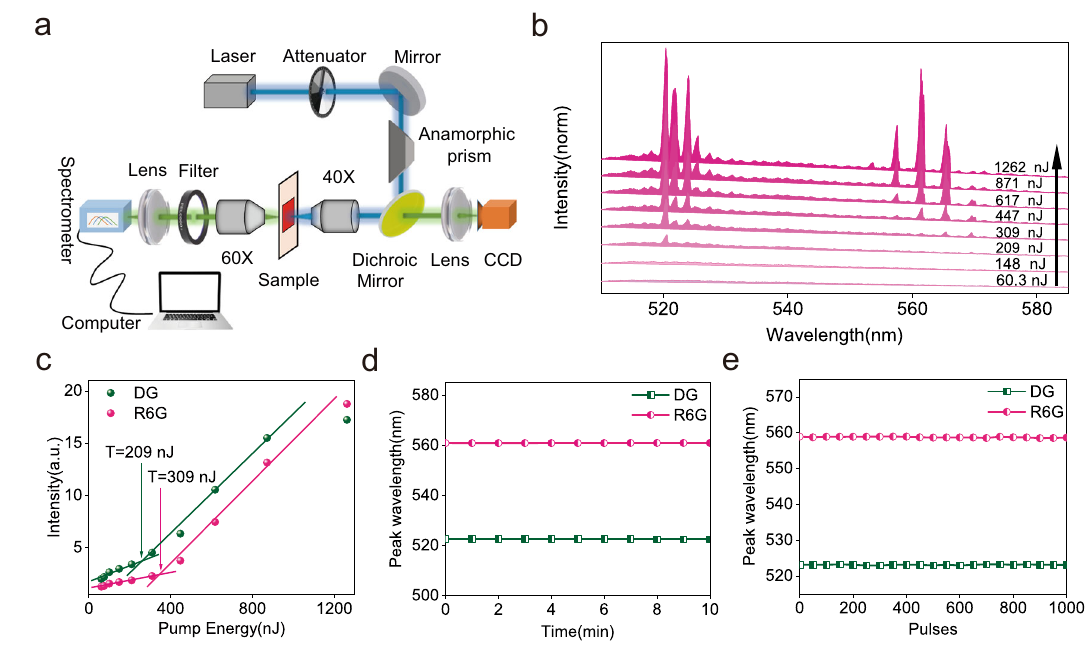
Fig. 1 | Dual-lasing of DG and R6G via an optical microcavity. a Schematic representation of the optical set-up (for details please see Methods section). b Typical lasing spectra of a DG microsphere in 50 µ M R6G under varied pumping